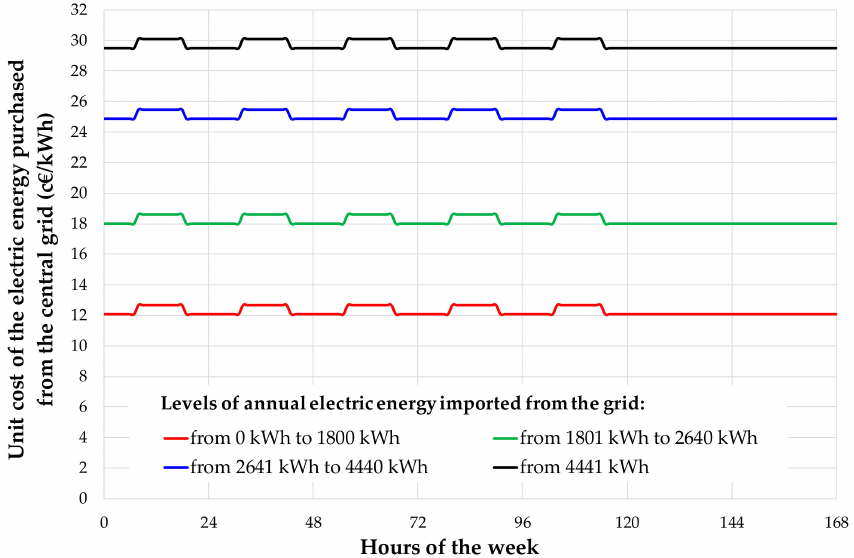
Figure 3. Weekly profile of the unit cost of the electric energy purchased from the central grid as a function of the time and cumulated levels of annual electric energy imported from the grid for Naples